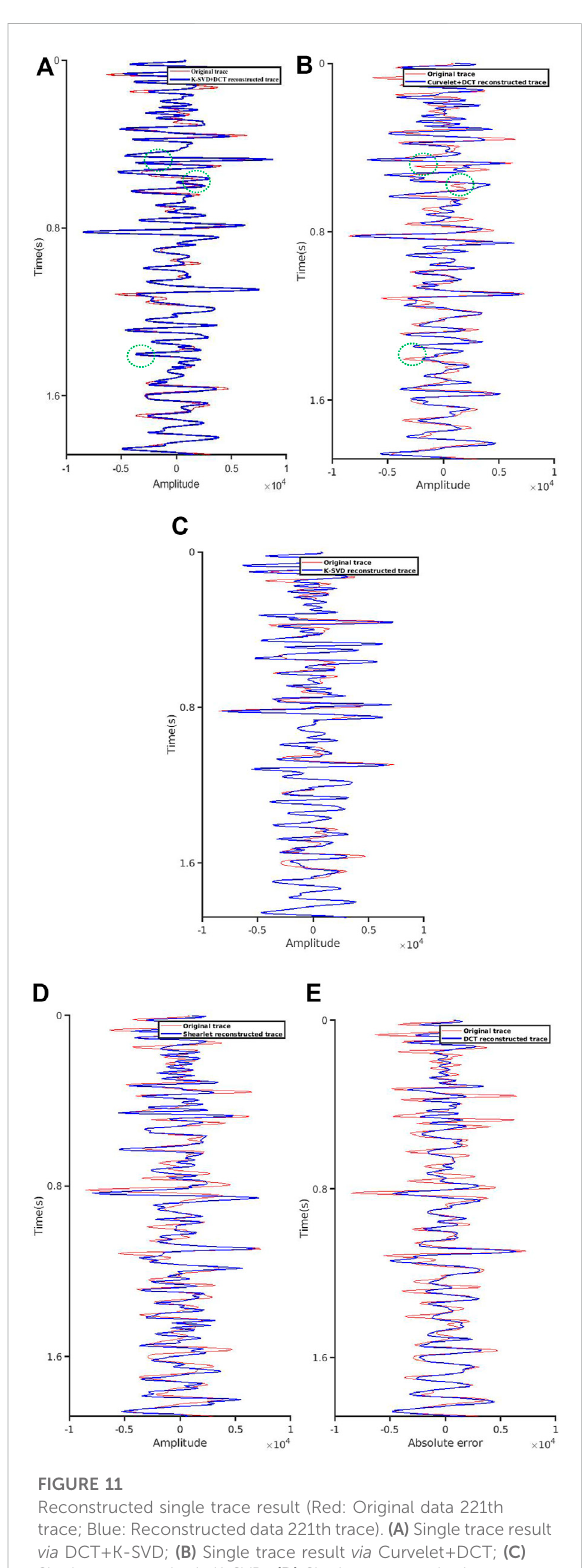
FIGURE 11 Reconstructed single trace result (Red: Original data 221th trace; Blue: Reconstructed data 221thtrace). (A) Single trace result via DCT+K-SVD; (B) Single trace result via Curvelet+DCT; (C) Single trace result via K-SVD; (D) Single trace result via Shearlet; (E) Single trace result via